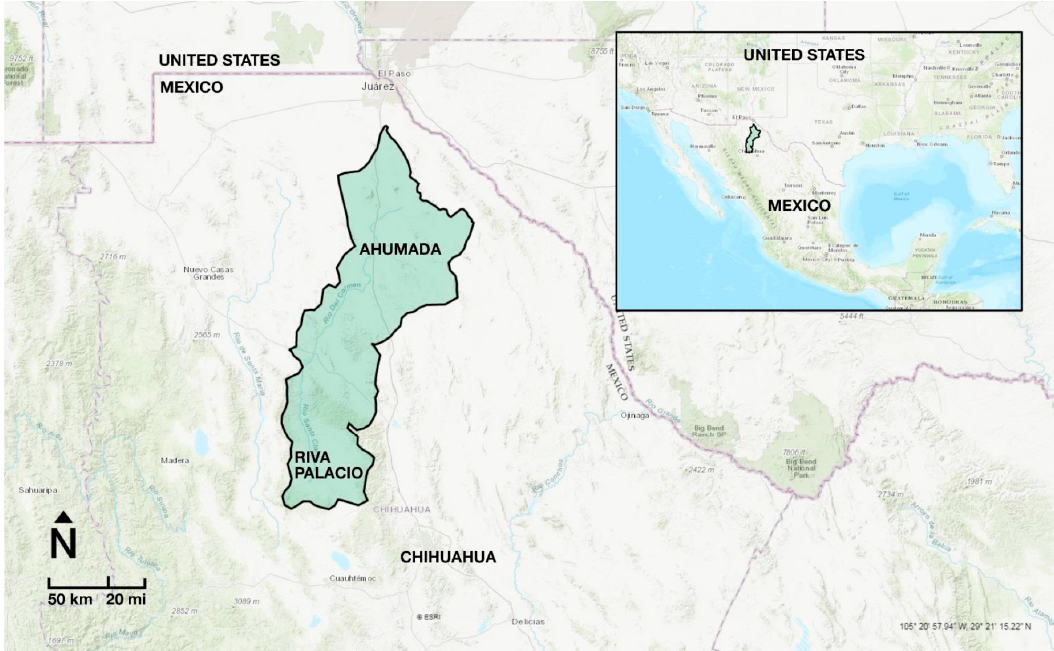
Figure 1. The Rio del Carmen watershed. Image obtained from the National Institute of Statistic and Geography of Mexico [42].